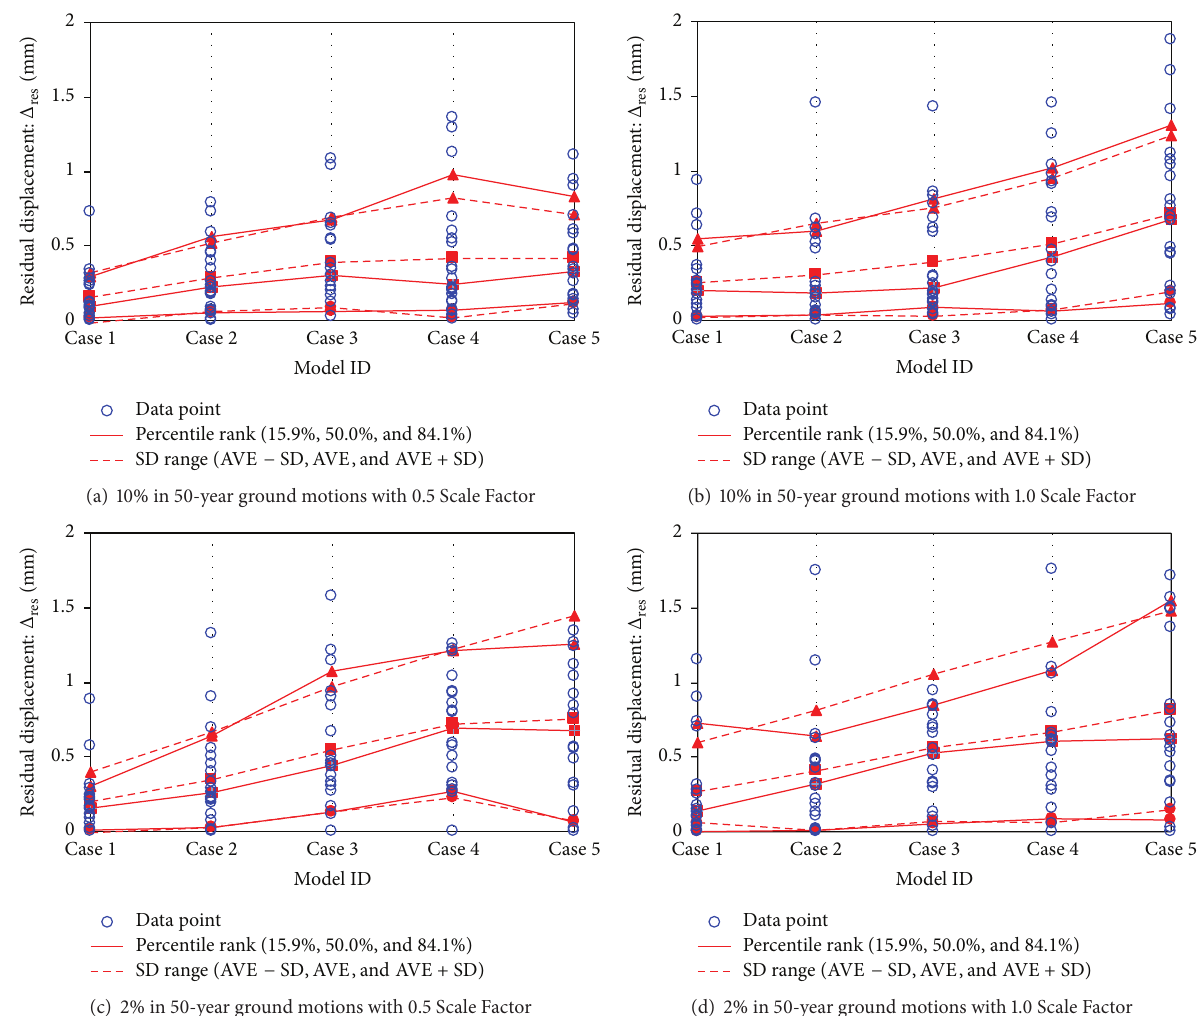
Figure 14: Residual displacement ( Δ res ) for individual SFDB models under 40 ground motions with different SFs.